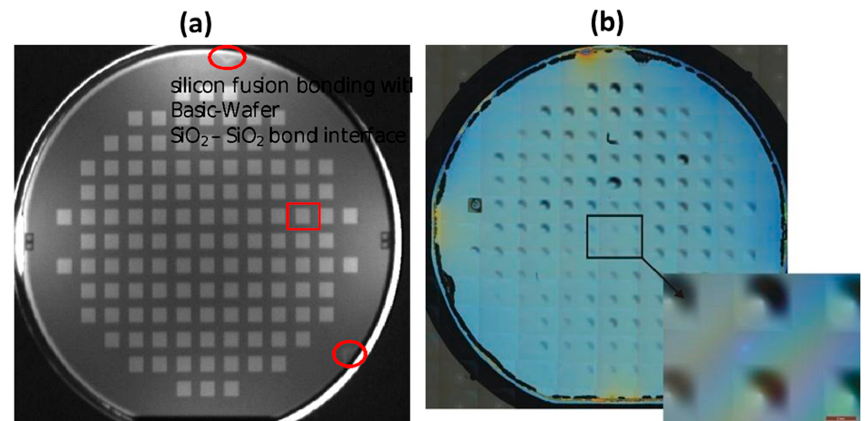
Figure 15. Customized “home-made” silicon-on-insulator (SOI) substrate with embedded cavity for z-scanner: ( a ) Infrared (IR) transmission of bonding interface; and, ( b ) microscope image of the membrane side.